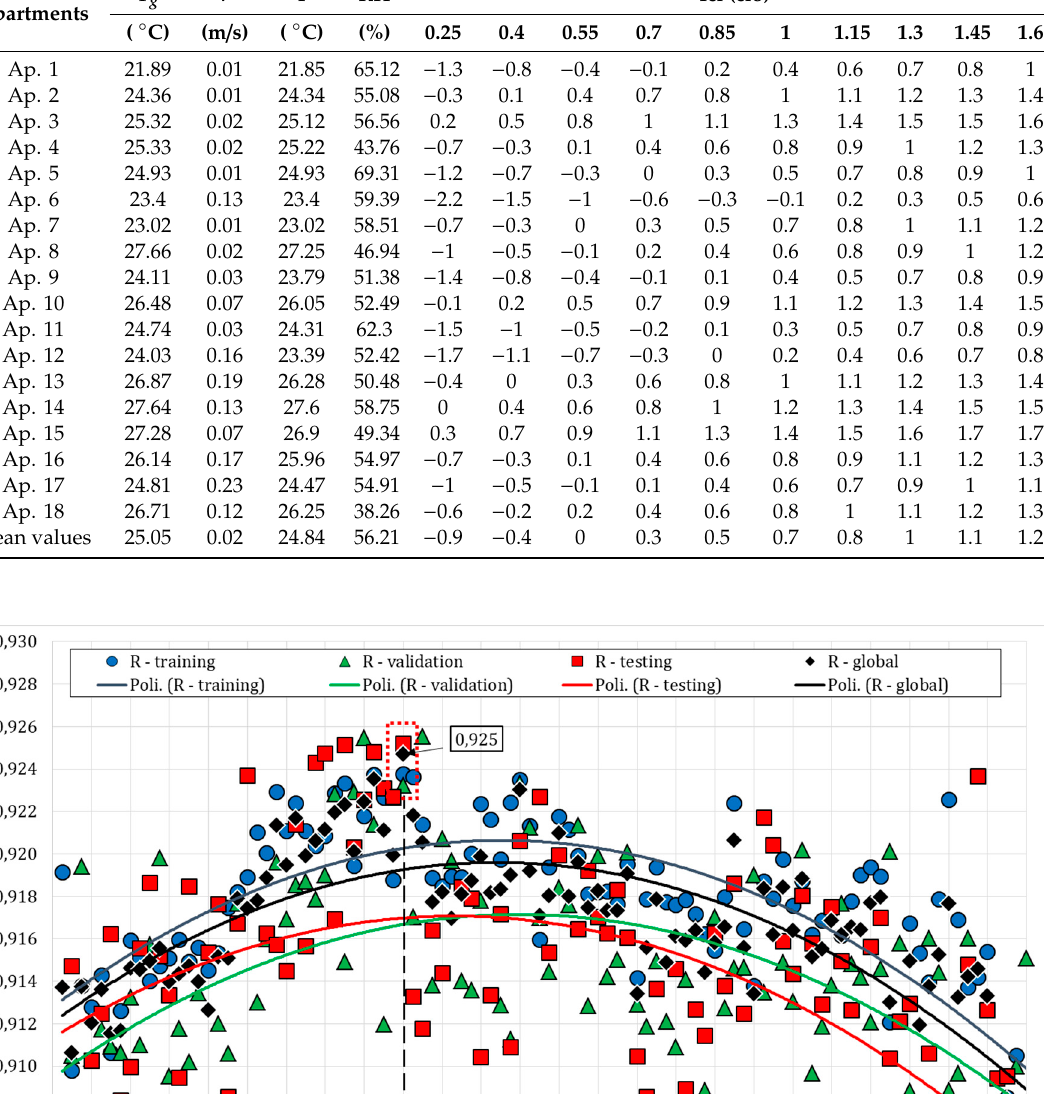
Table 4. Mean values of the variables provided as input or target data from apartment 1 to 13 used for the training, validation and testing sub-processes, data from apartment 14 to 18 for the generalization process of the ANN.